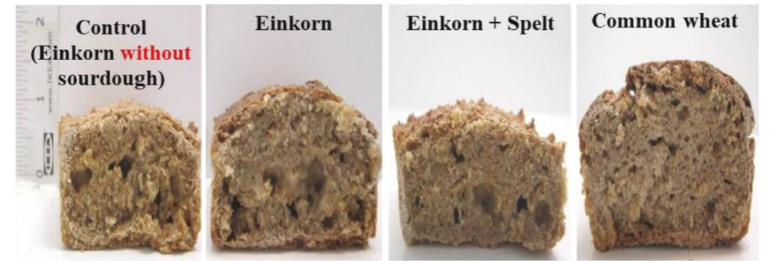
Figure 3. Section aspect of the bread samples made from ancient grains flour using sourdough method. Adapted from Sereti et al. [114]. Copyright 2020 Creative Common Attribution License.